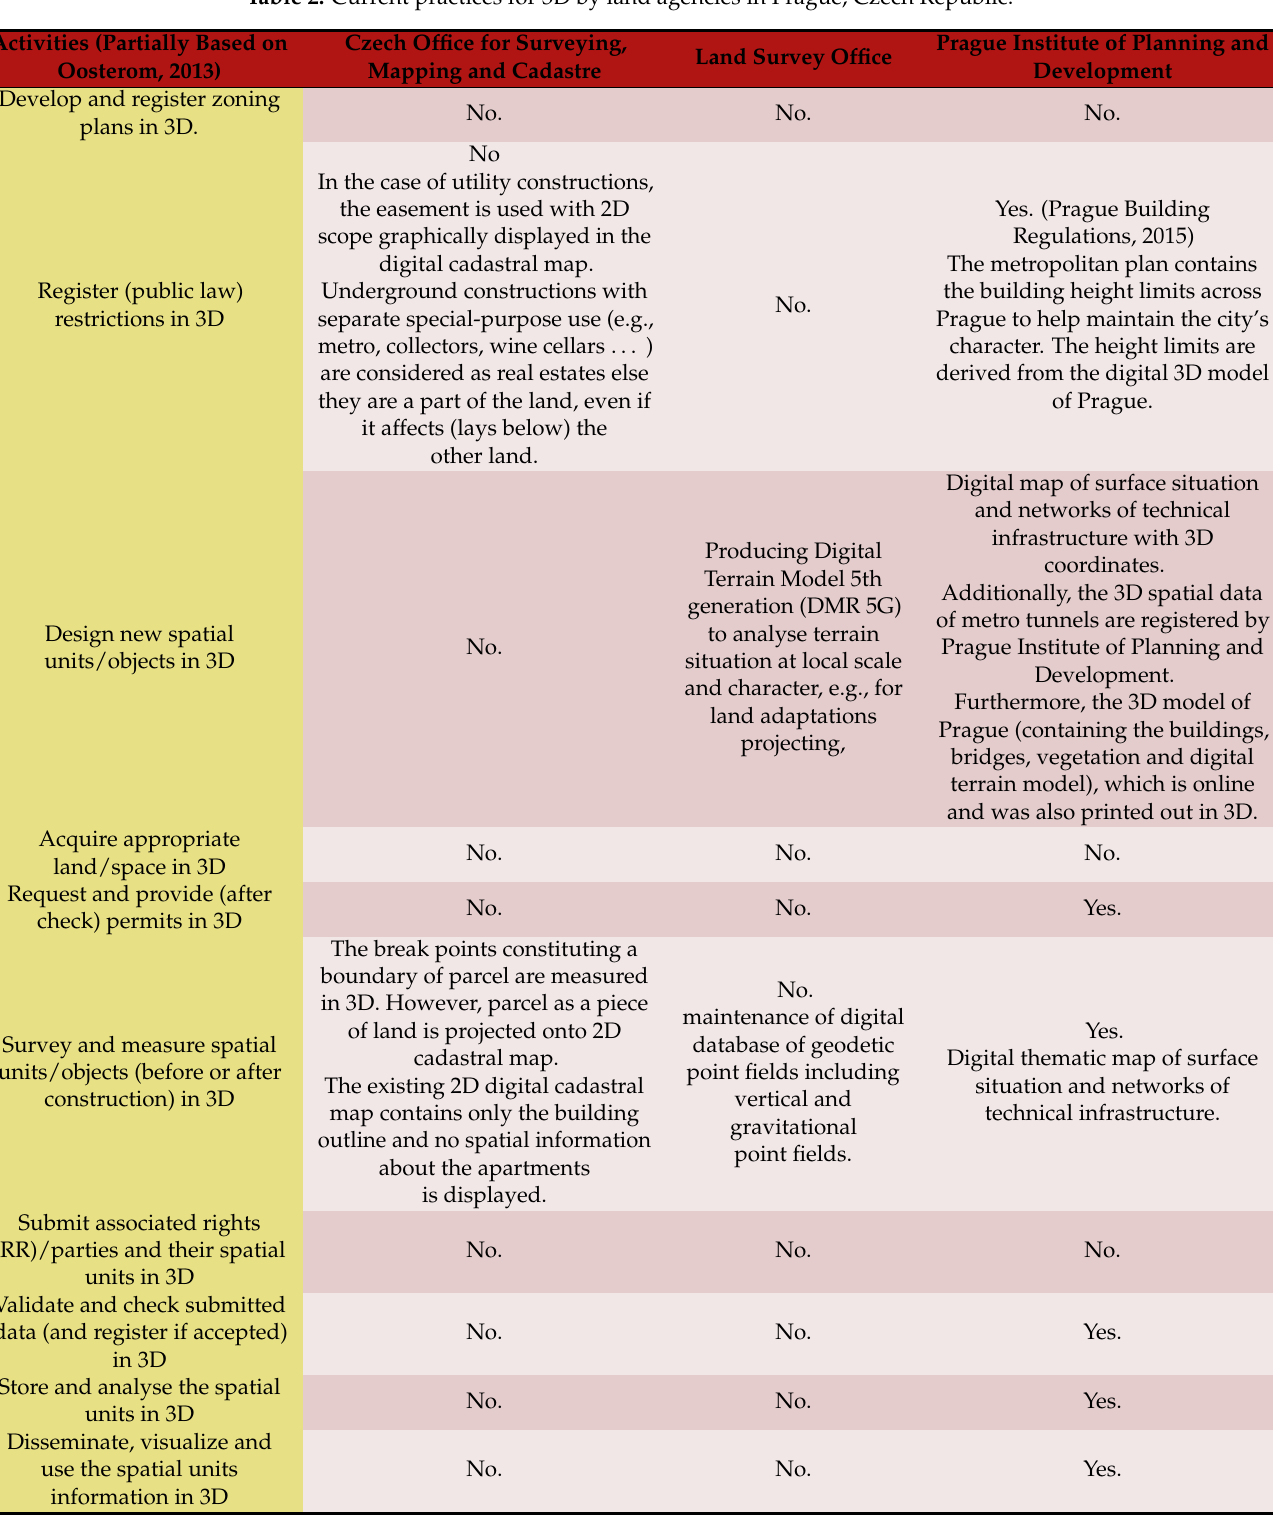
Table 2. Current practices for 3D by land agencies in Prague, Czech